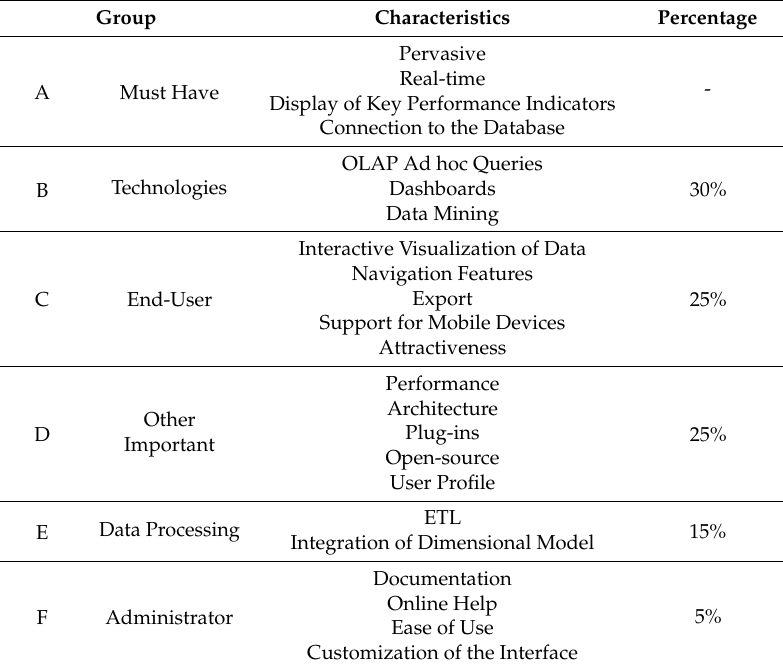
Table 2. The groups, features associated, and respective